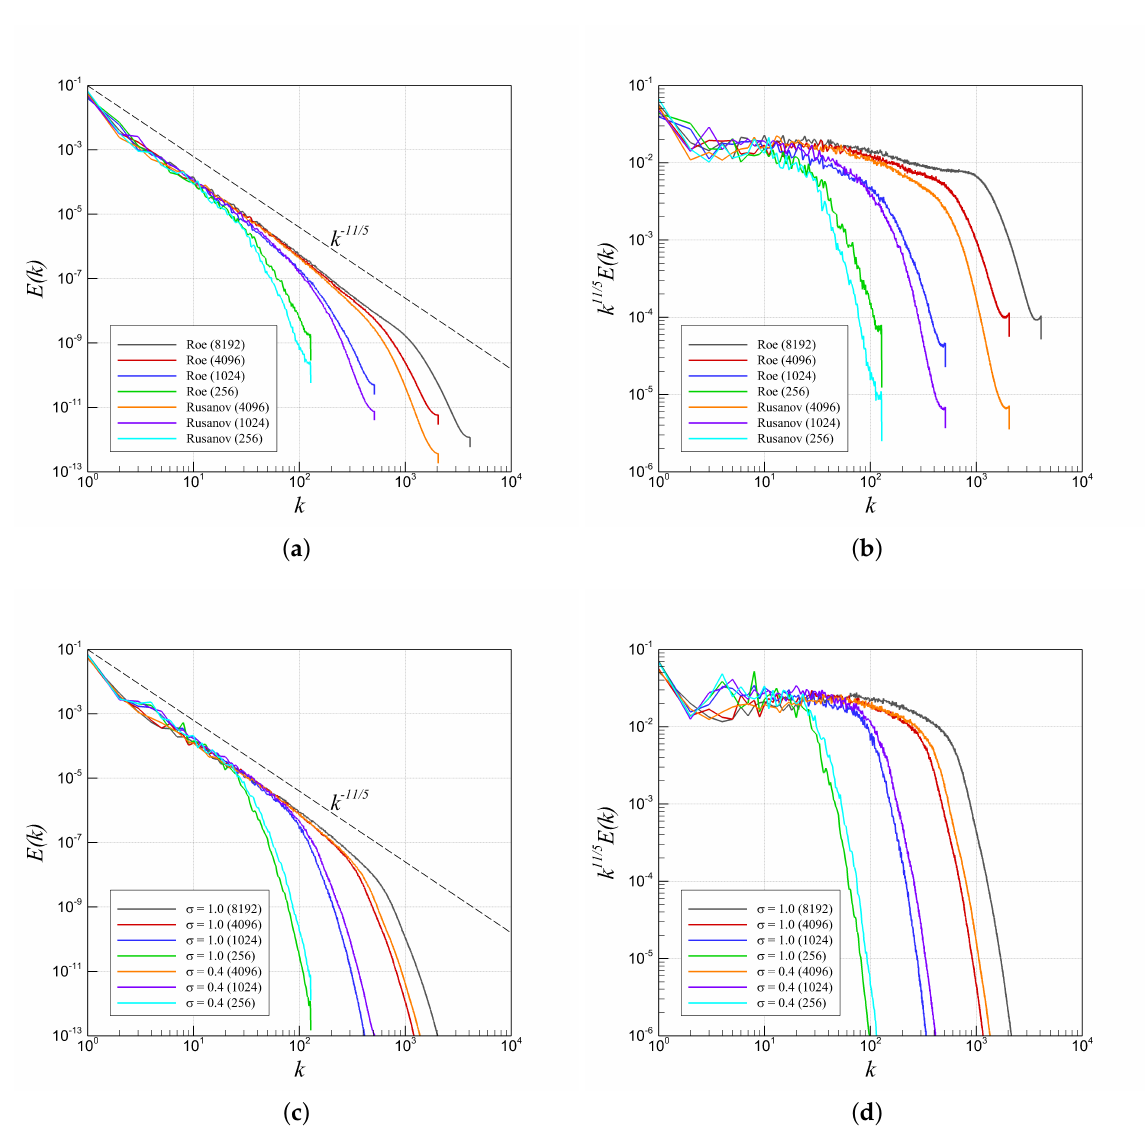
Figure 24. Comparison of ILES (ILES-Roe and ILES-Rusanov) models and CS+RF ( σ = 1.0 and σ = 0.4) models at different resolutions for the RTI problem with single-mode perturbation showing the kinetic energy spectra and compensated kinetic energy spectra; ( a ) kinetic energy spectra using ILES solvers; ( b ) compensated kinetic energy spectra using ILES solvers; ( c ) kinetic energy spectra using CS+RF solvers; ( d ) compensated kinetic energy spectra using CS+RF